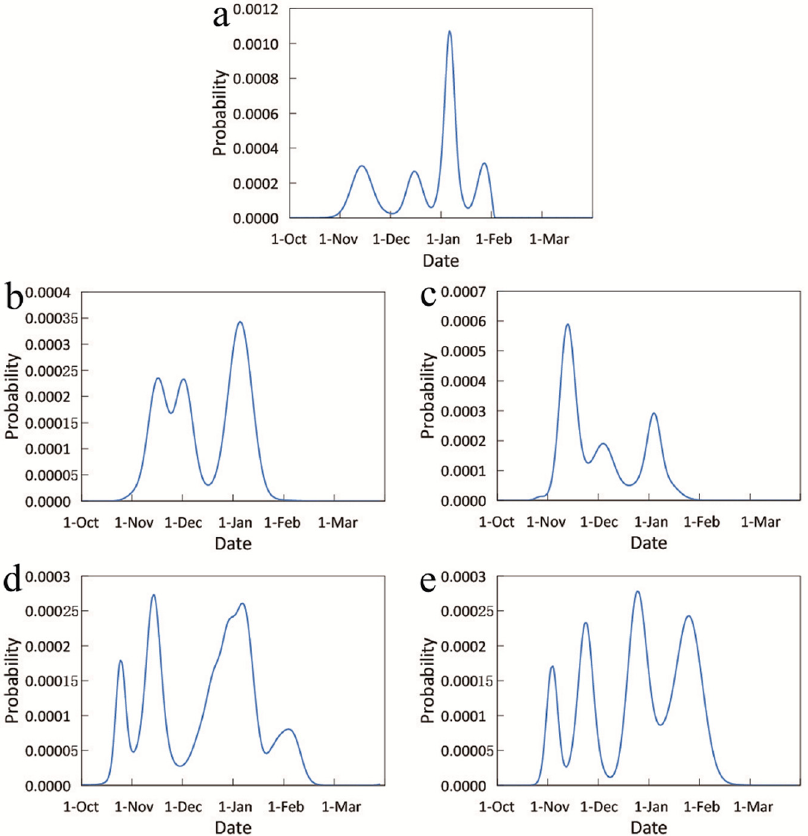
Figure 13. Encounter probability of drought occurrence dates in the non-flood season. ( a ) The reference period. ( b ) 2020–2049 period of scenario A2. ( c ) 2070–2099 period of scenario A2. ( d ) 2020–2049 period of scenario B2. ( e ) 2070–2099 period of scenario B2.